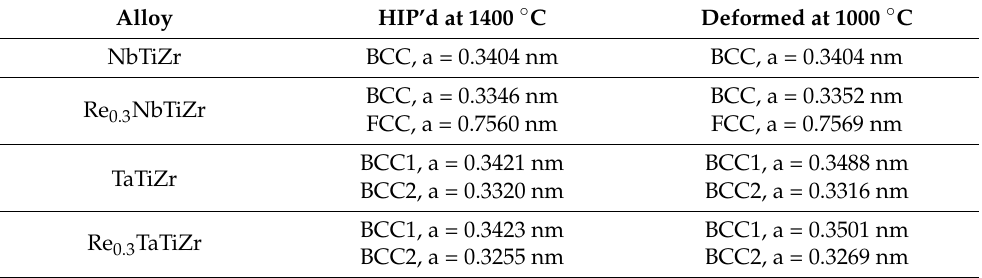
Table 4. Lattice parameters of the observed phases in the studied alloys after HIP’ing at 1400 ◦ C or compression deformation at 1000 ◦